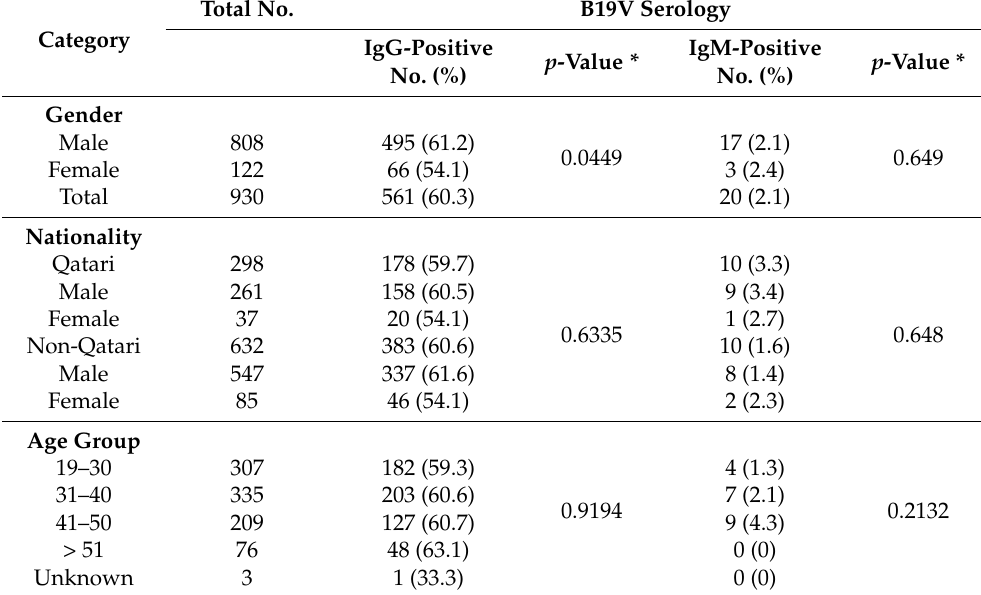
Table 5. B19V seroprevalence in the studied population ( n =